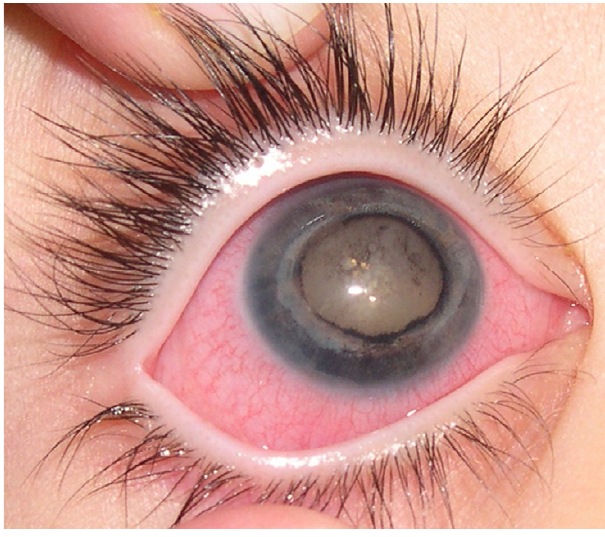
Figure 3 Coats' disease: histopathological findings. Total exsudative retinal detachment